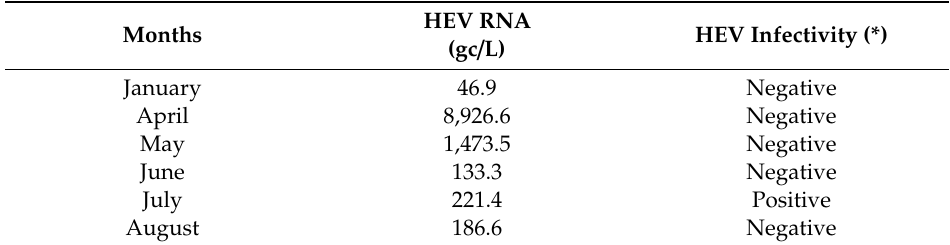
Table 5. Evaluation of concentrated water samples from a sampling point in the distribution network, for the presence of HEV RNA and infectious particles. Months